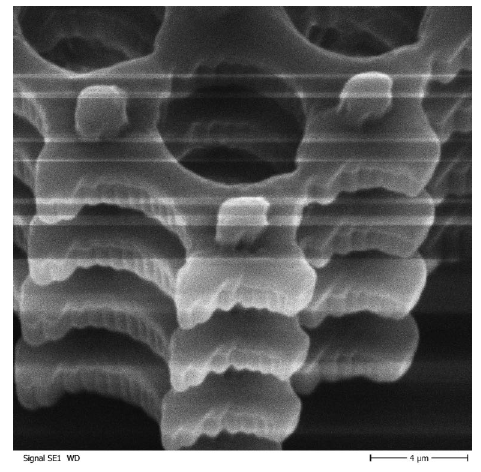
Figure 6. Structure with 200nm layer